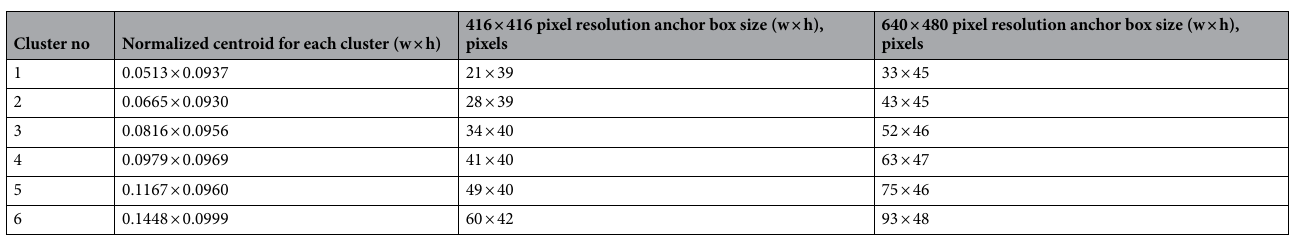
Table 4. Anchor box sizes chosen by k-means